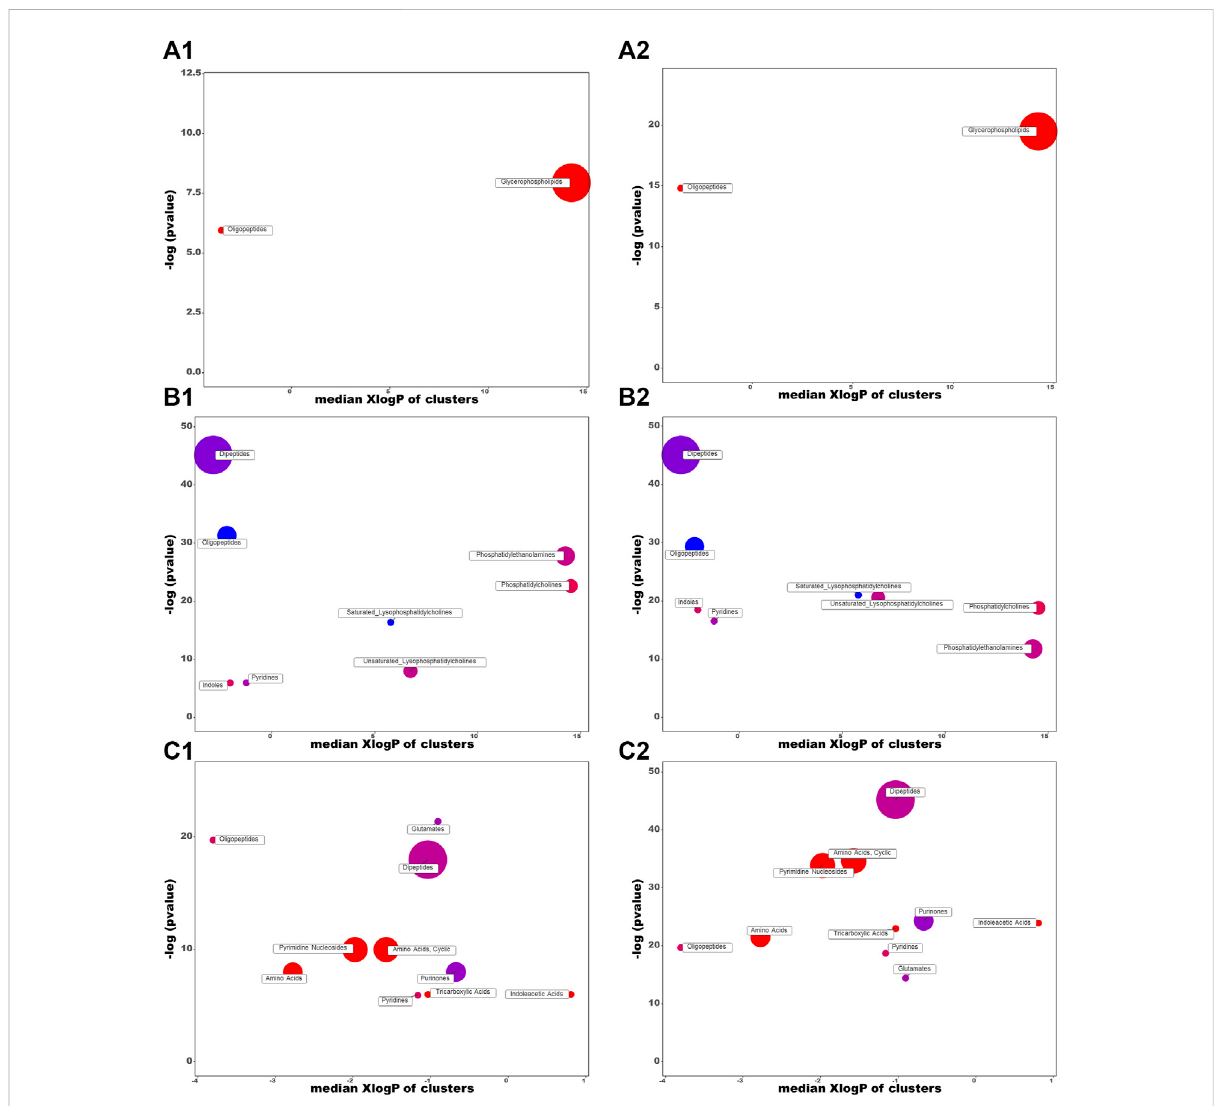
FIGURE 5 Chemical similarity enrichment analysis of the HK- attenuated PBs in the serum (A) , kidney (B) , and urine (C) . (1) and (2) represent CDDP vs. Control and CDDP vs. CDDP + HK, respectively. Cluster colors give the proportion of increased or decreased compounds (red = increased, blue = decreased) in each cluster. Dots size indicates the number of PBs in each cluster. The top of the Y -axis shows the most obvious clusters. Chemical enrichment statistics are calculated by Kolmogorov – Smirnov